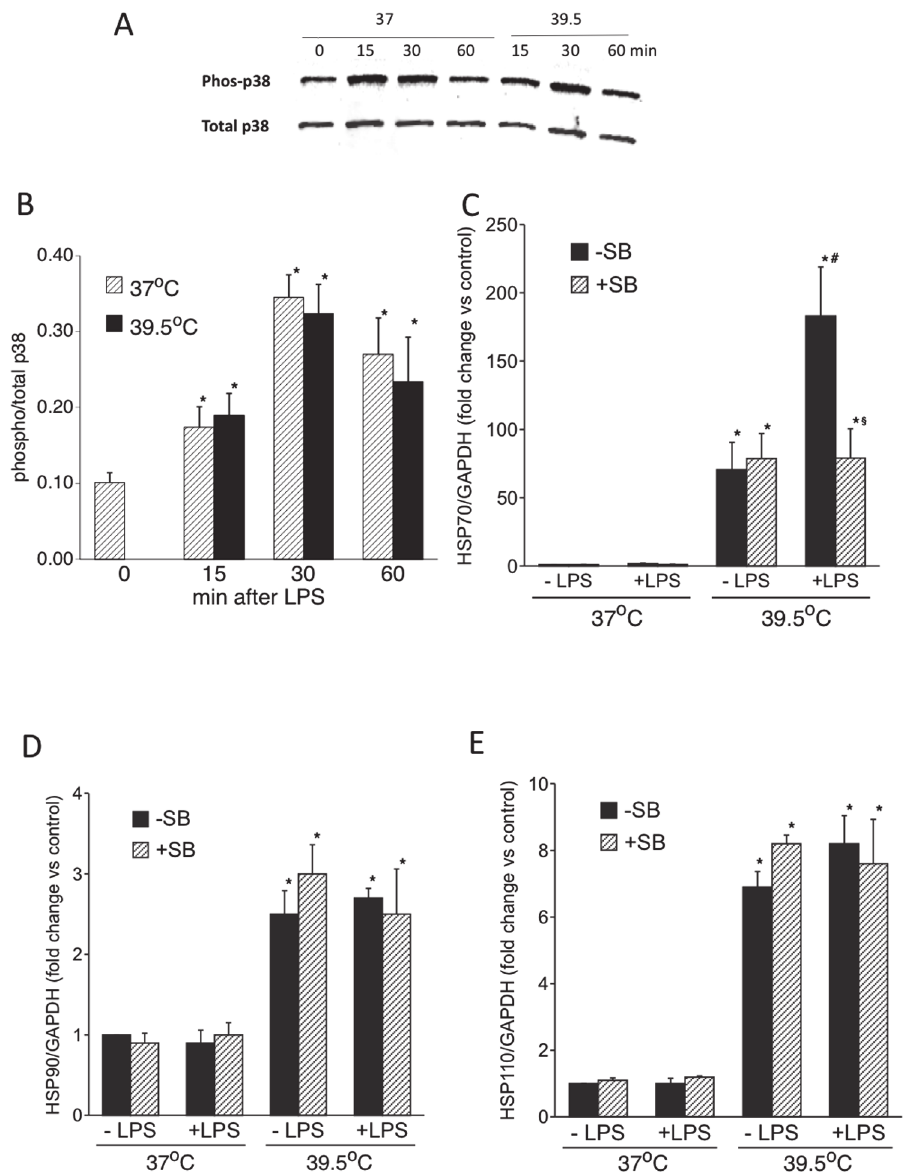
Fig 2. p38 MAPK inhibitor inhibits LPS-induced increase in HSP70 levels in FRH-exposed THP1 cells: A, B. Differentiated THP1 cells were incubated with or without 100 ng/ml LPS at 37° or 39.5°C. Cells were lysed at the indicated time and immunoblotted for phosphorylated and total p38 α / β . A representative blot and mean ± SE of band densities from four experiments plotted as the ratio of phosphorylated to total p38 are shown in A and B, respectively. C – E. Differentiated THP1 cells were pretreated with either 0.1% DMSO or 10 μ M SB203580 HCl (SB) in DMSO for 30 min and then stimulated with 100 ng/ml LPS for 2 h. RNA was isolated and HSP70 (HSPA1A) (B), HSP90 (HSP90AA1) (C), and HSP110 (HSPH1) (D) mRNA was quantified by qPCR, normalized to GAPDH, and expressed as fold change vs. untreated 37°C control. Data presented as mean+SE, n = 4. * , # and § denote p < 0.05 vs. 37°C controls, LPS-untreated 39.5C cells, and SB203580-untreated cells, respectively.